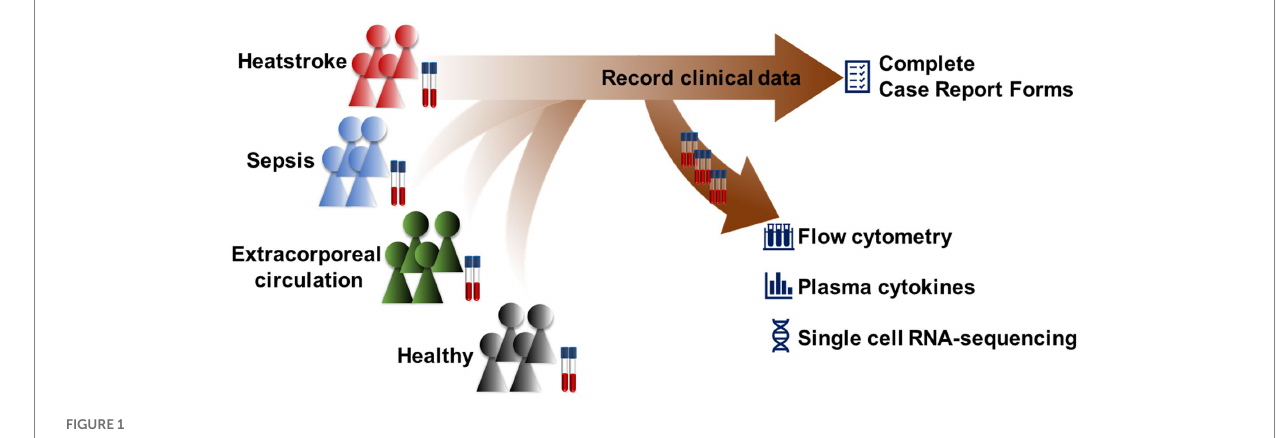
FIGURE 1 Presentation of the study design.